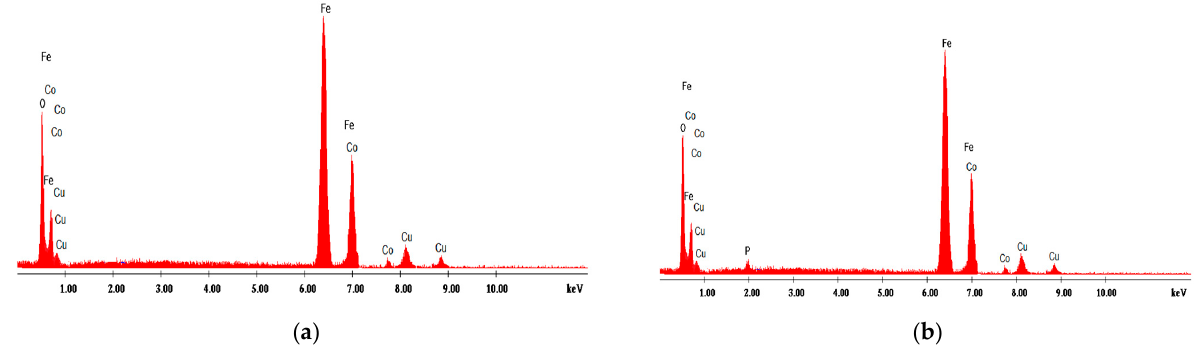
Figure 2. EDX analysis of cobalt ferrite ( a ) before and ( b ) after phosphorus adsorption.